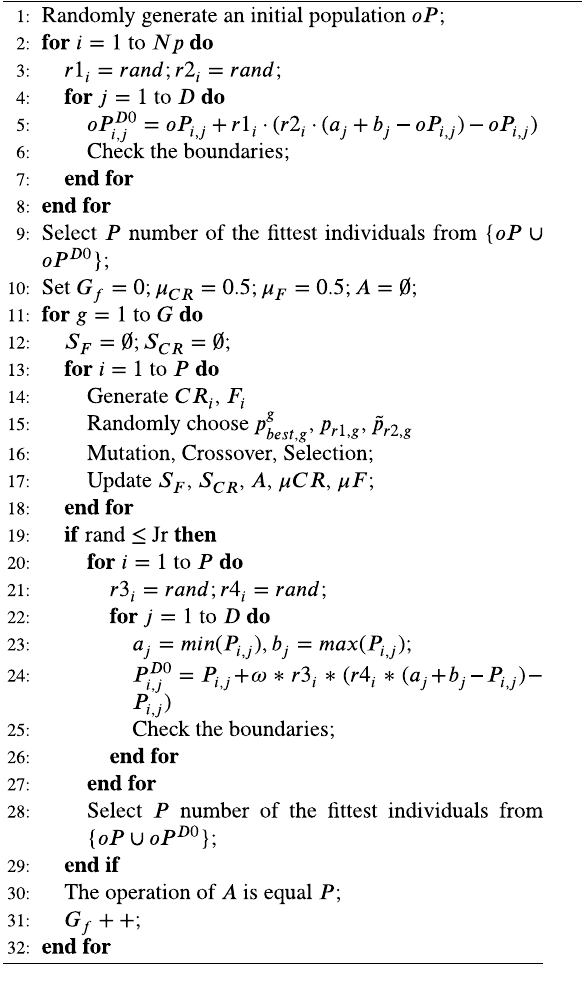
TABLE 3 | Parameters of the involved algorithms.